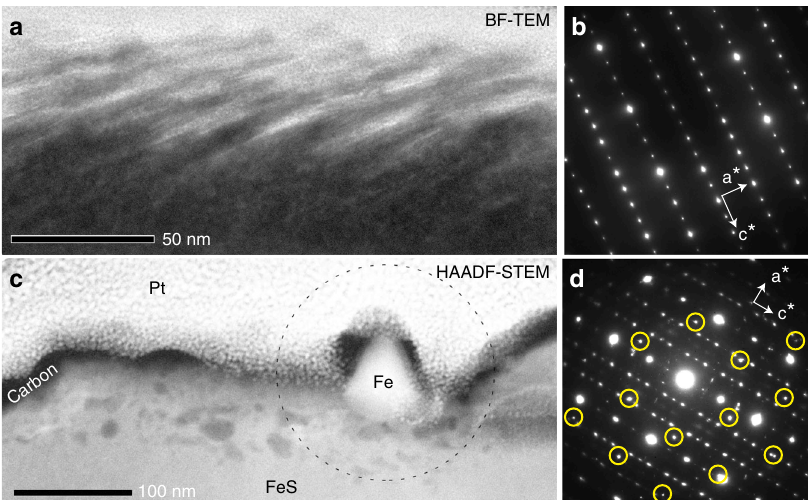
Fig. 3 Structures of altered rims on troilite. a A TEM-BF image of a troilite surface with open vesicles when viewed edge-on. b A SAED pattern of troilite obtained from the same sample direction as ( a ). c A HAADF-STEM image of troilite with internal vesicles. Dark patches beneath the troilite surface correspond to vesicles. An iron whisker is present on the troilite. d A SAED pattern from the circled area in ( c ). Spots from a single bcc iron having a zone axis of [111] are circled. The troilite diffraction pattern is slightly diffuse due to misorientation. a-b was obtained from a FIB section RA-QD02-0325-01 (Supplementary Fig. 1). c-d was obtained from FIB section RA-QD02-0286-01 (Supplementary Fig.